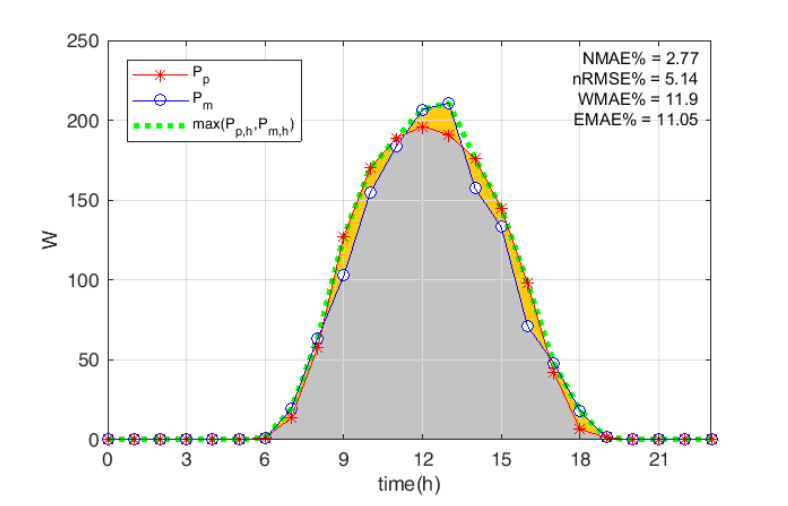
Figure 9. Example of a sunny day forecast—1 April 2014—with the relevant evaluation indexes. EMAE %: envelope-weighted mean absolute error.